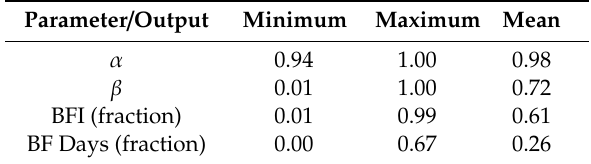
Table 1. Minimum, maximum, and mean values for accepted model parameters and